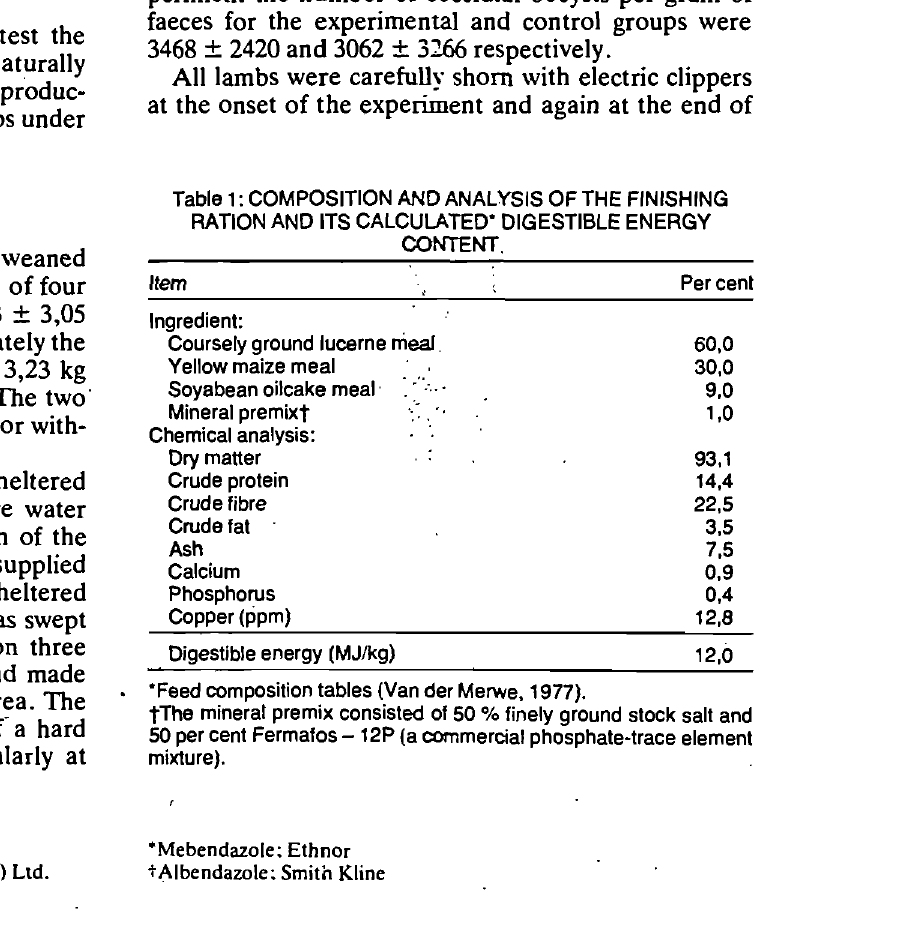
Table 1: COMPOSITION AND ANALYSIS OF THE FINISHING RATION AND ITS CALCULATED" DIGESTIBLE ENERGY